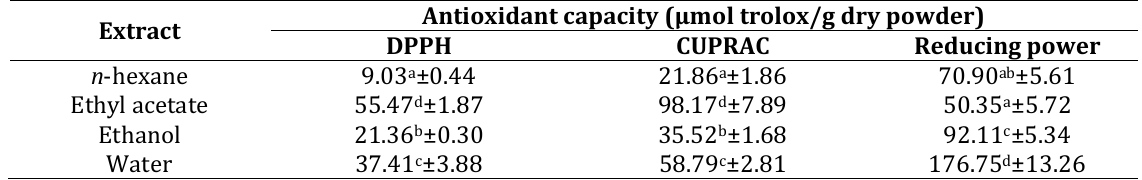
Table II. The capacity of antioxidant activity with different methods of DPPH, CUPRAC, and reducing power assay (n =